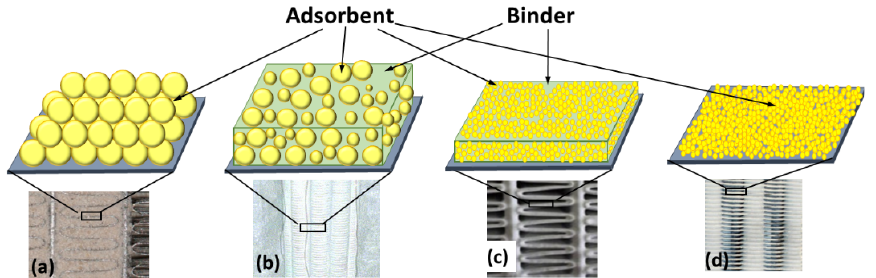
Figure 2. Various adsorbent bed configurations: loose grains ( a ) [16]; consolidated bed ( b ) [19]; binder-based coating ( c ) [20]; and in situ synthesized coating ( d ) [21].